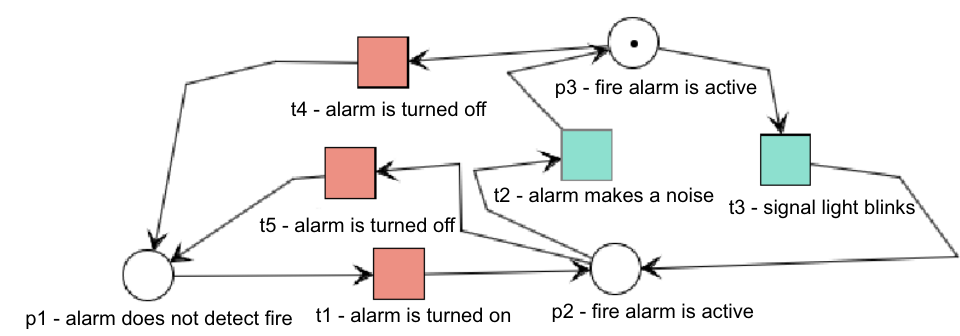
Figure 10. Petri Net for fire alarm ( t 2 is fired).